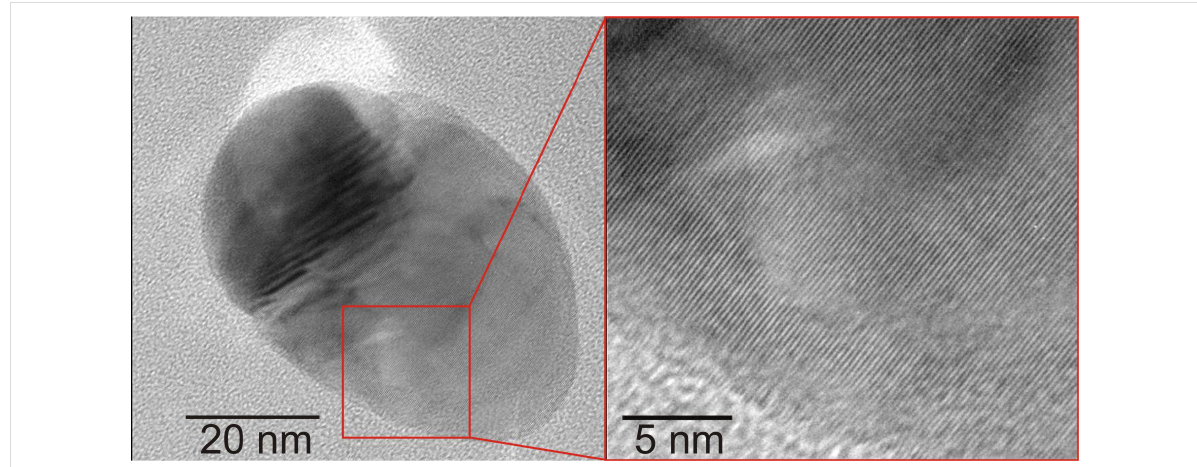
Figure 5: High-resolution TEM image of a silver nanoparticle grown by enzymatic synthesis. The right part shows a detail at higher magnification with clearly observable crystallographic planes of silver.